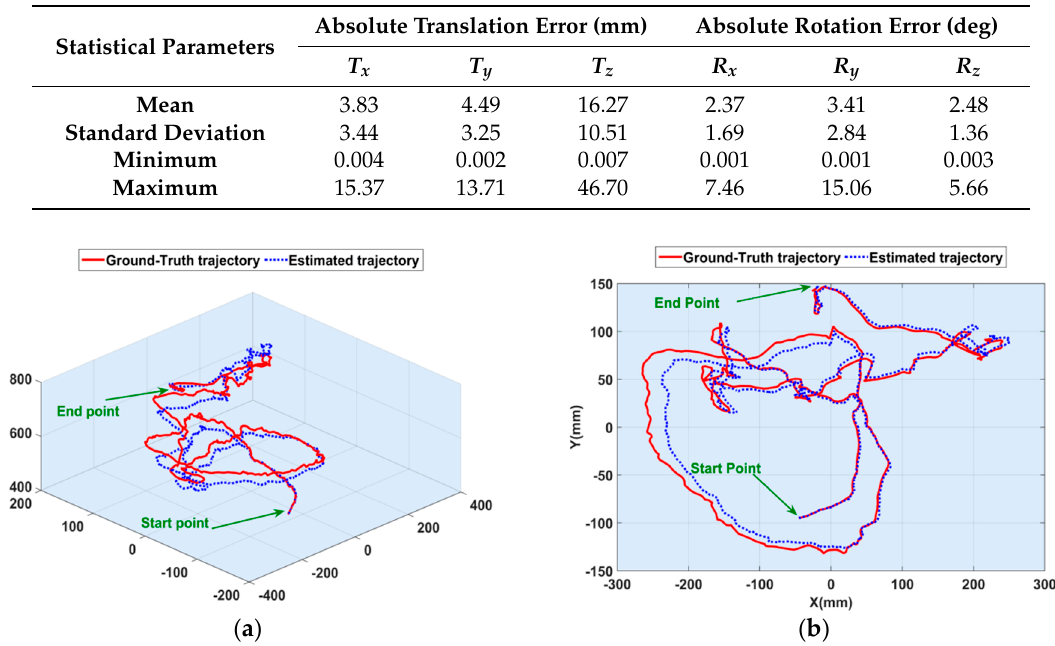
Figure 5. Camera trajectory estimated using PF versus ground truth data: ( a ) 3D view; ( b ) projections of estimated and ground truth trajectories on the XY plane.